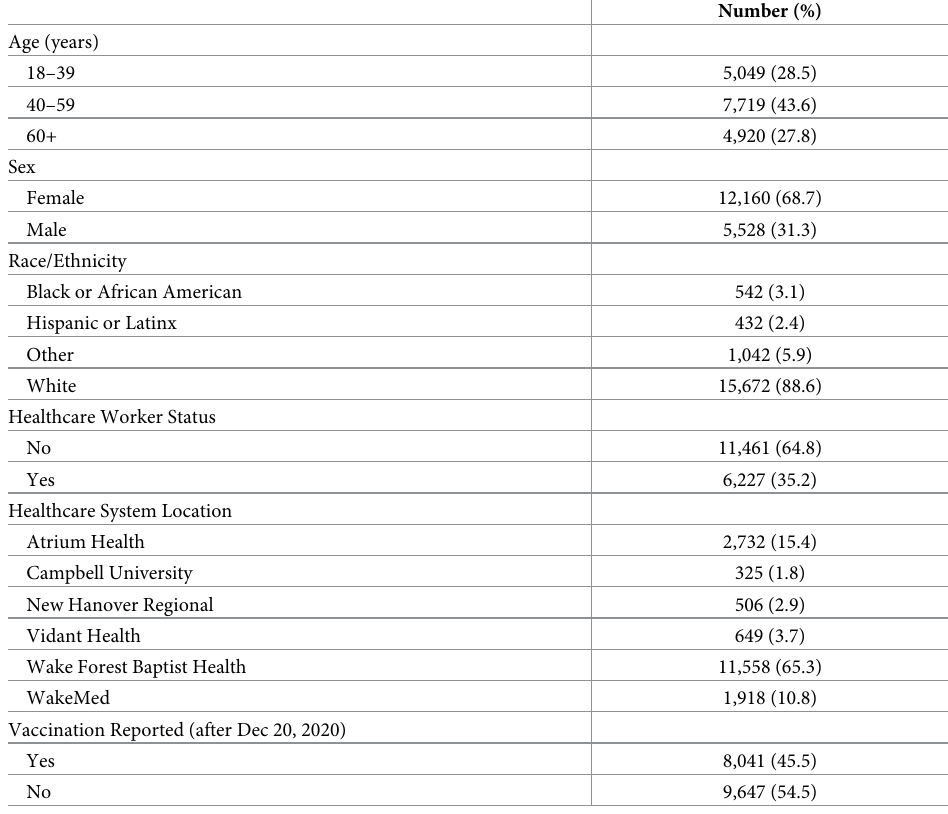
Table 1. Characteristics of North Carolina CCRP participants in the serology analysis (n =